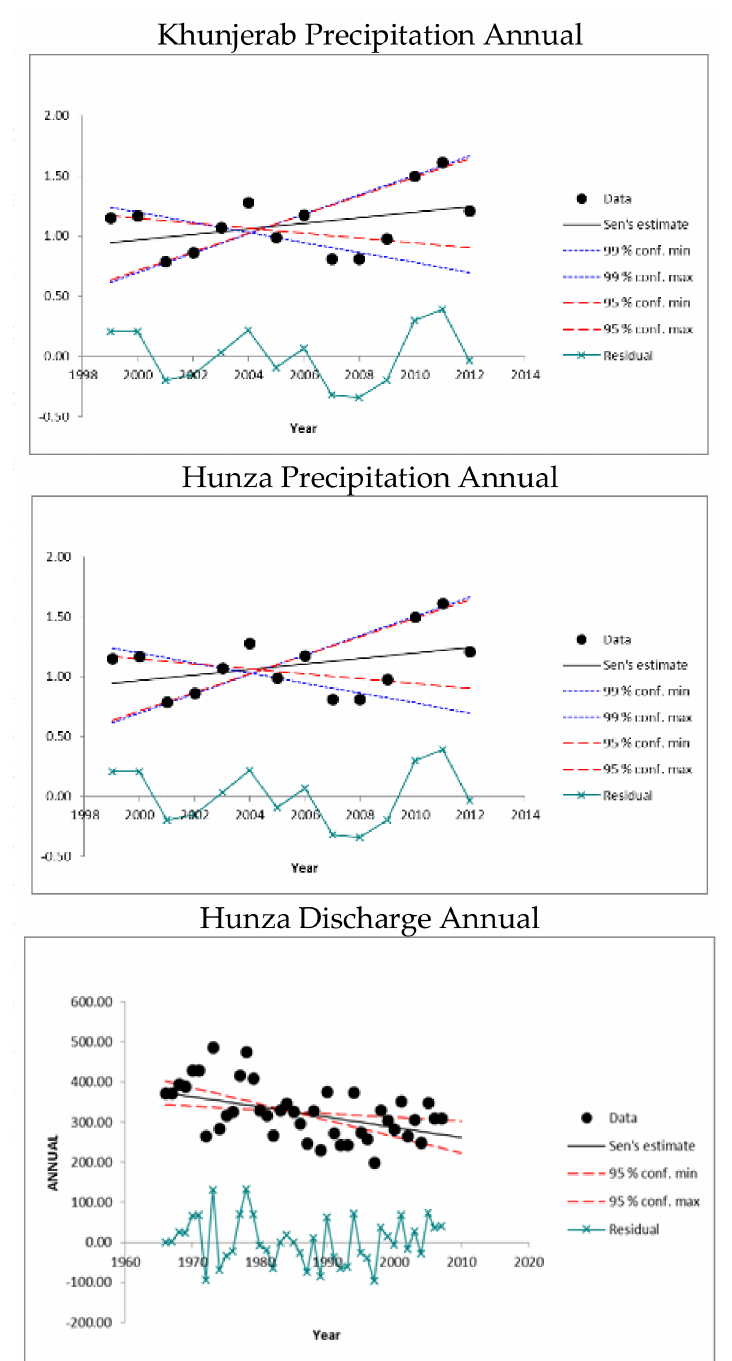
Figure A2. Hunza sub-basin’s hydrometeorological trends of different